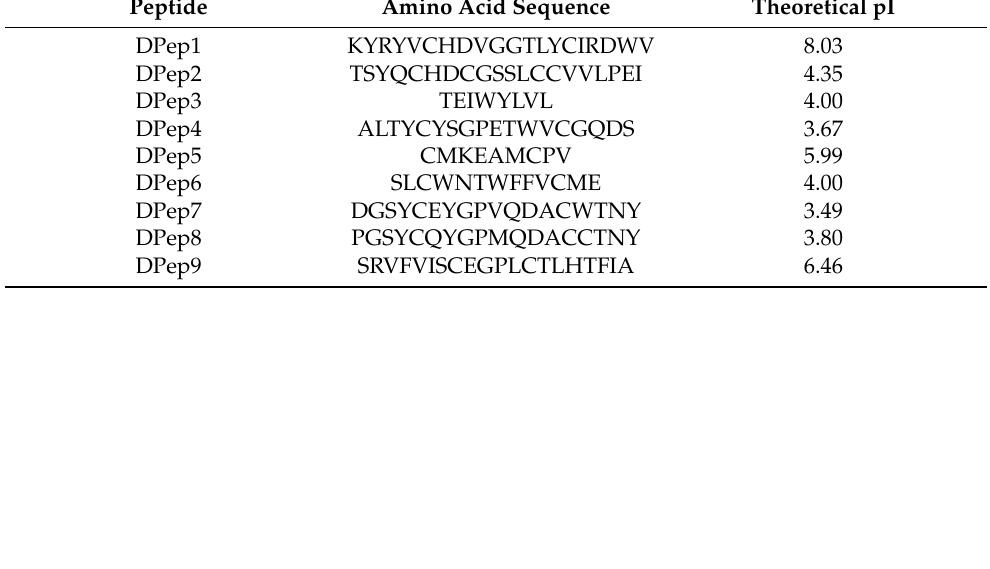
Table 1. Amino acid sequences of DPep1 peptide and PvP